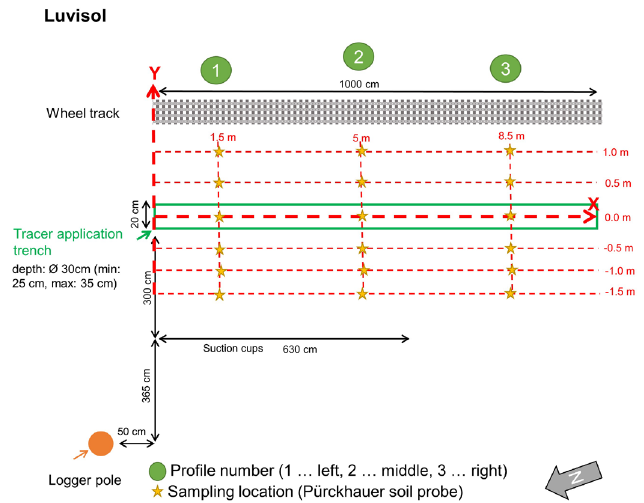
Figure A1. Location of the tracer application trench and soil sampling locations in reference to the suction cup profile of the Luvisol.